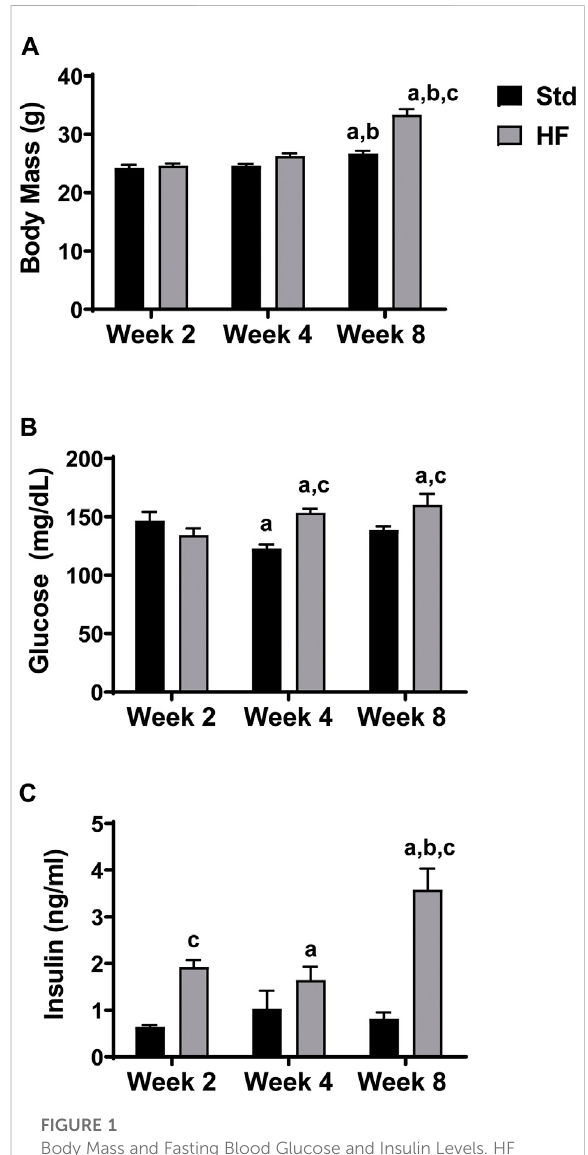
FIGURE 1 Body Mass and Fasting Blood Glucose and Insulin Levels. HF exhibitgreaterbodymass (A) ,fastingbloodglucose (B) ,andinsulin (C) levels compared to Std after 8 weeks of dietary intervention. a p < 0.05 vswk 2within diet, b p < 0.05vswk4within diet,and c p < 0.05 for Std vs HF within the week. Data are presented as mean ± SEM ( n = 11 – 12 mice per